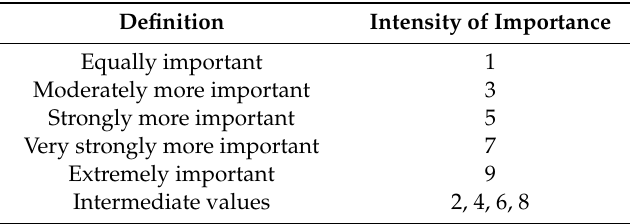
Table 1. Nine-point scale suggested by Saaty [10].